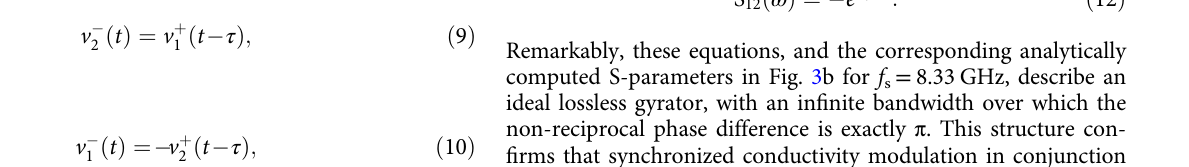
and two polarity inversions that negate each other in the second half cycle. On the other hand, signals traveling from right to left experience a single-polarity inversion in both half cycles. In time domain, this functionality results in